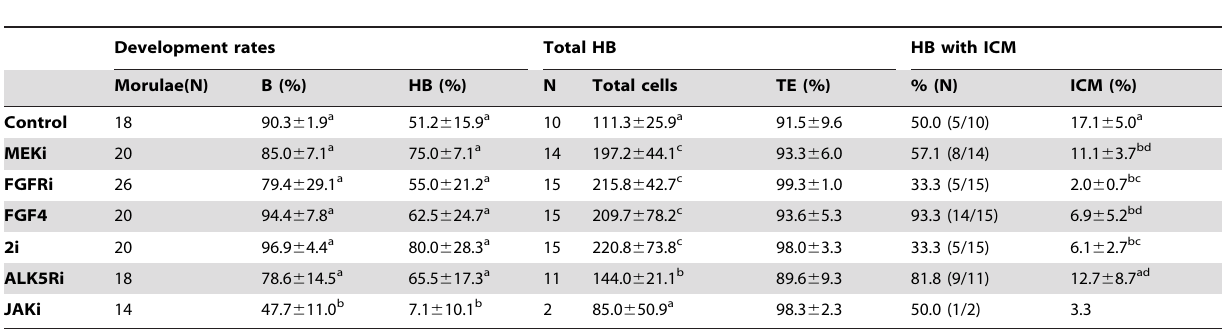
Table 2. Developmental capacity of pig morulae incubated with small molecule inhibitors.